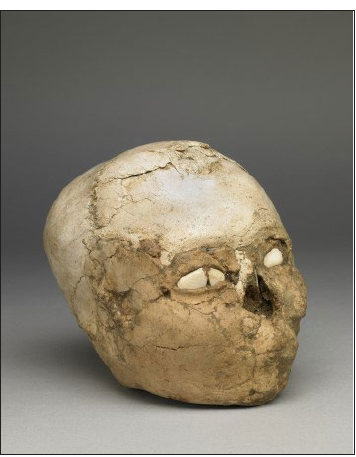
Figure 1: The Jericho Skull excavated by Kath- leen Kenyon from the Neolithic site at Jericho (8500–9,300 years old) (© The Trustees of the British Museum) (The British Museum, N.D).